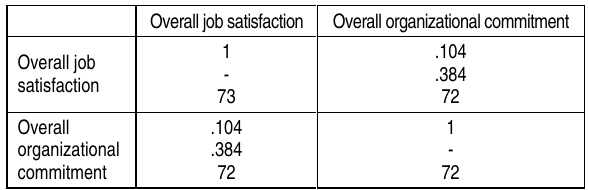
Table 5. Overall correlations